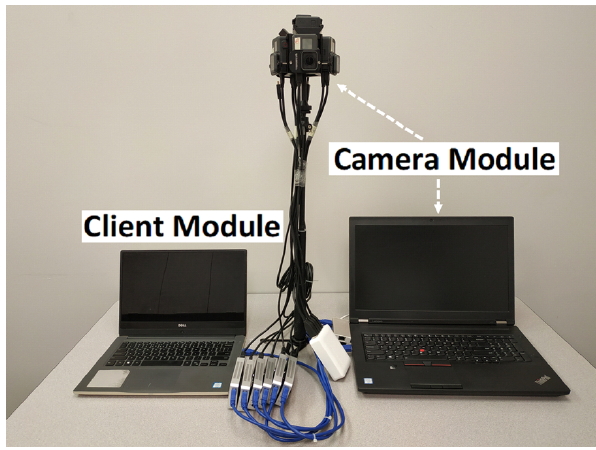
Figure 2. The Zeus